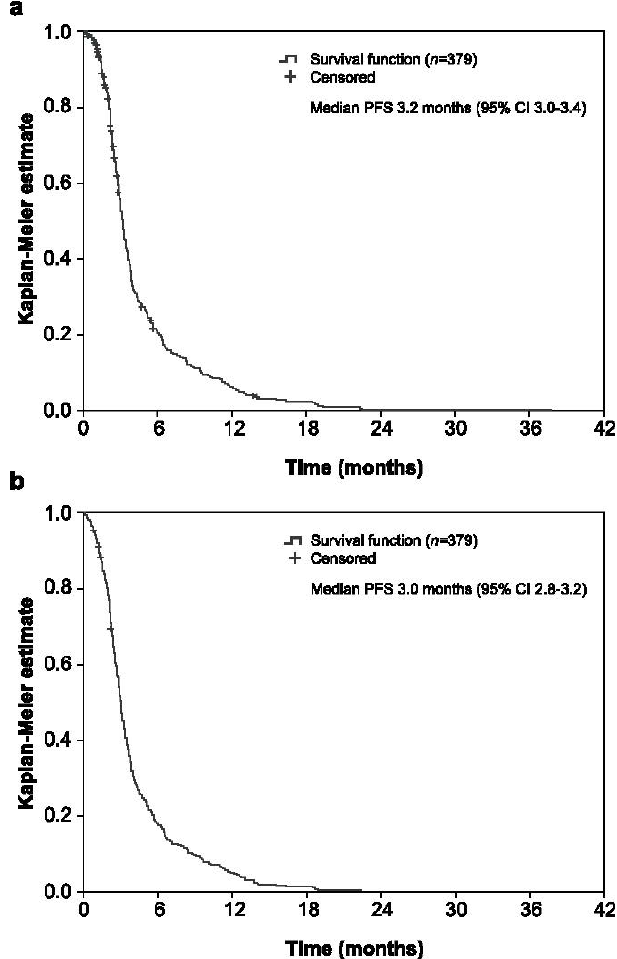
Figure 3. Kaplan–Meier plots for progression-free survival considering radiologic disease progression ( a ) and clinical disease progression ( b ). CI: confidence interval, PFS: progression-free